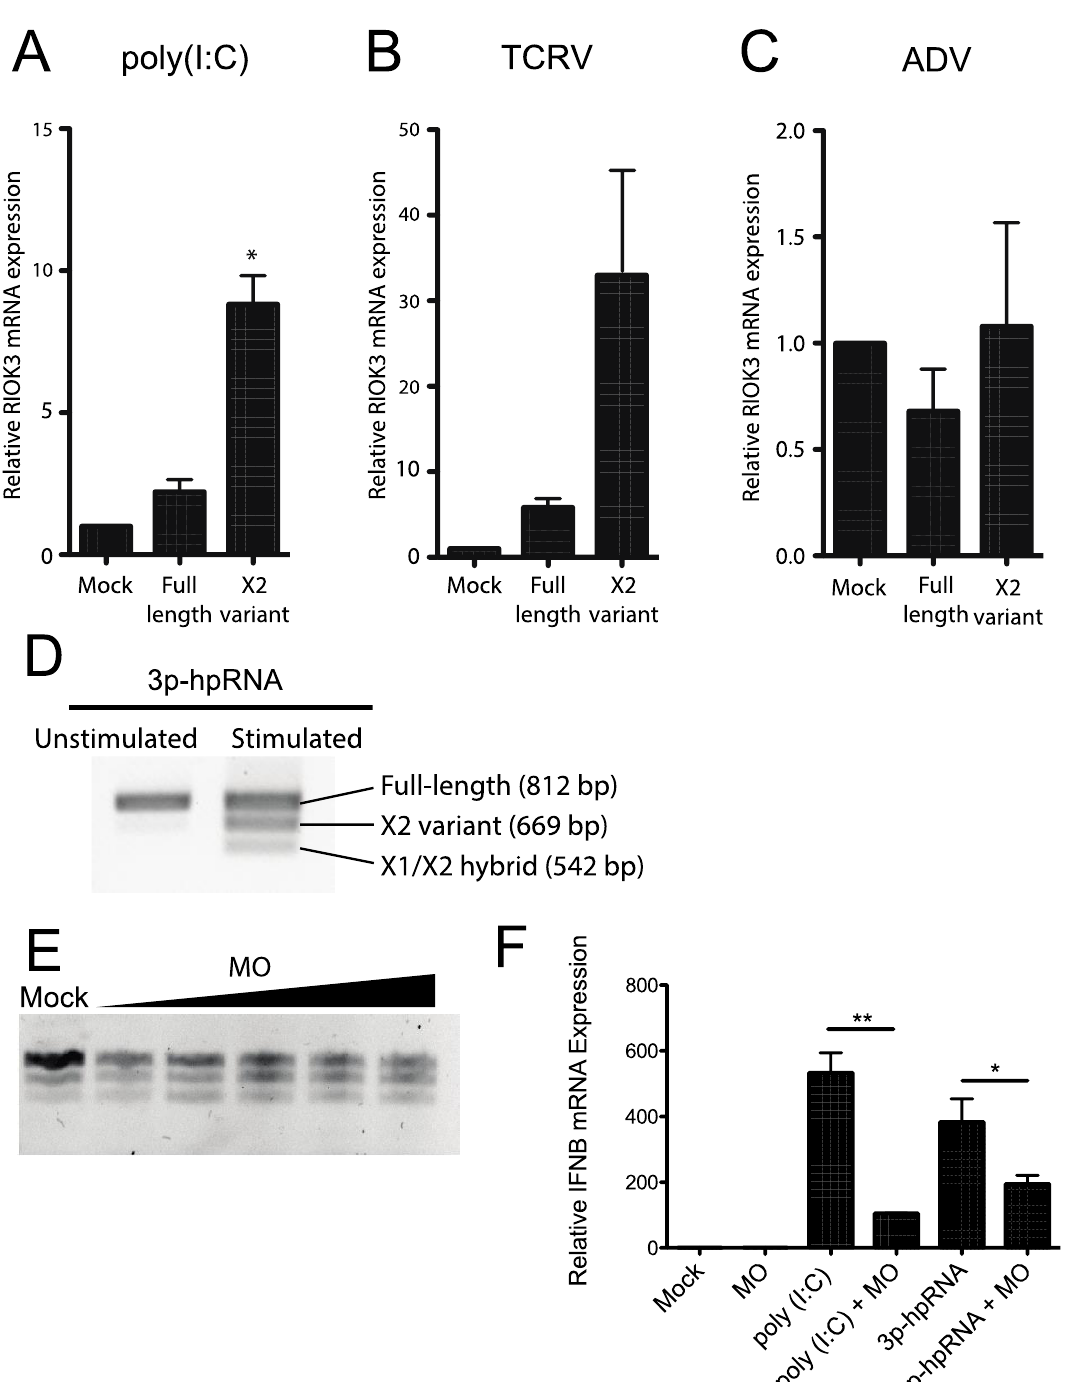
Figure 4. Activation of cytosolic innate immune RNA sensors, but not DNA sensors induces RIOK3 X2 variant alternative splicing, and RIOK3 splicing is vital for IFN expression. HEK293 cells were transfected with poly (I:C) ( A ), or infected with either the RNA virus Tacaribe (TCRV) ( B ), or the DNA virus adenovirus (ADV) ( C ). Total RNA was harvested 24 h post transcription or infection and RT-qPCR was used to quantify the relative fraction of X2 variant and full-length canonically spliced RIOK3 species. Data are presented as mean +/ − SEM based on duplicate experiments. Student’s t -test: * p <